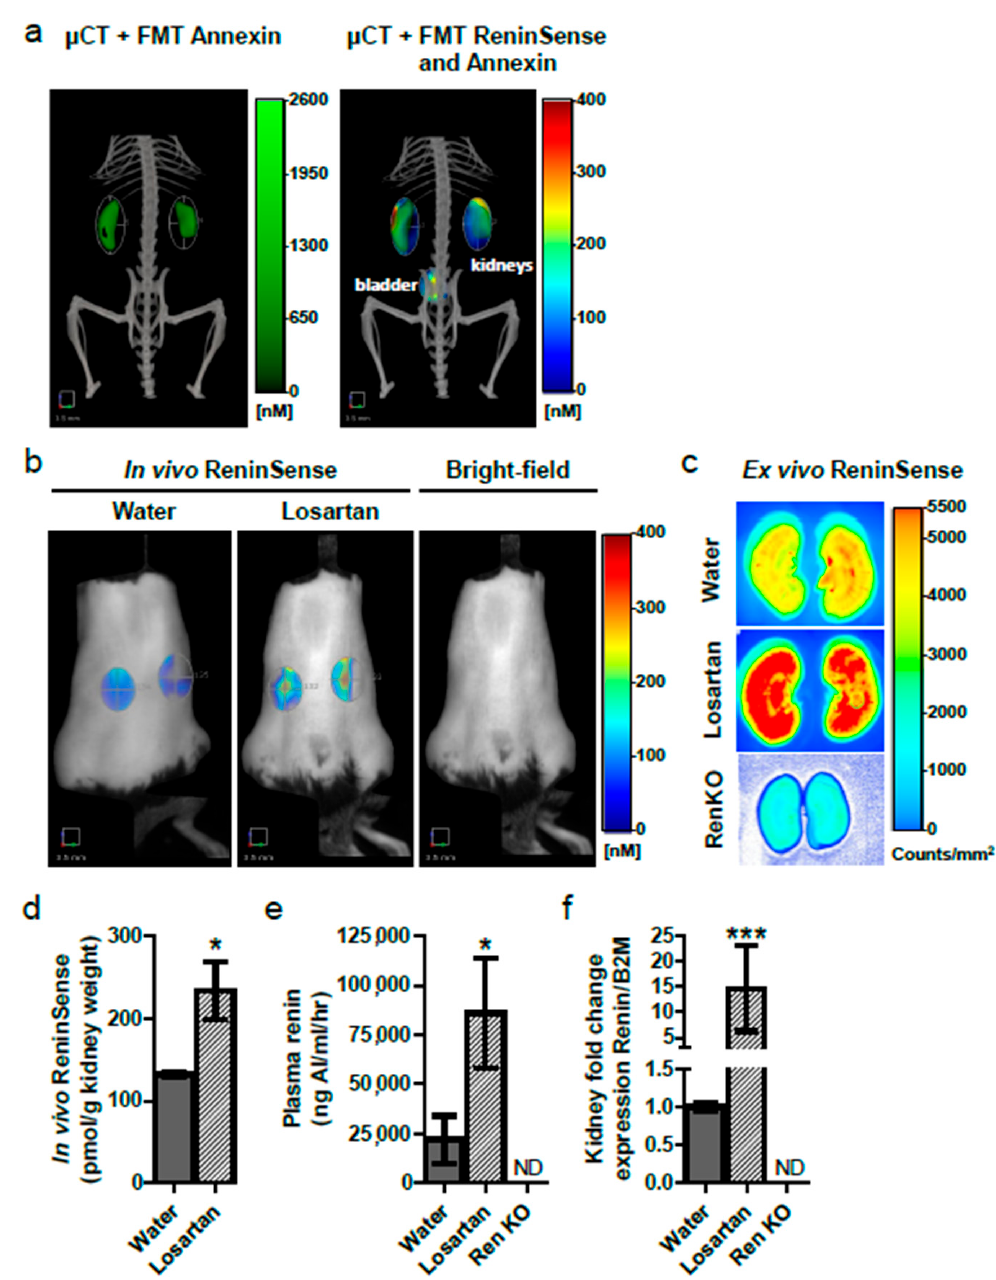
Figure 4. In vivo activation of ReninSense in kidneys of WT mice, with and without losartan treatment. ( a ) Mice were imaged tomographically by FMT 2500 and microCT 24 h after ReninSense injection. Micro CT imaging and FMT imaging of Annexin-Vivo allowed accurate localization of the kidneys. Combined microCT and FMT imaging of Annexin-Vivo and ReninSense showed in vivo renin activity in the kidneys and bladder (clearance of probe). ( b ) Losartan-treated mice showed increased in vivo intrarenal renin activity, which was confirmed by quantification. ( c , d ) Ex vivo imaging of the kidneys by the Odyssey ® system confirmed activation of the ReninSense probe in losartan-treated mice. Fluorescence of ReninSense could not be detected in vivo or ex vivo in RenKO mice. ( e ) Losartan treatment increased plasma renin activity. ( f ) Increased expression levels of renin in the kidneys were found in losartan-treated mice. ND, not detectable. Data are means ± SEM of n = 3. Note: * p < 0.05, *** p < 0.01 vs.